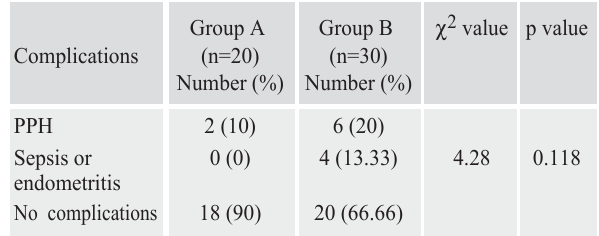
Table I: Units of blood transfusion per patient Units